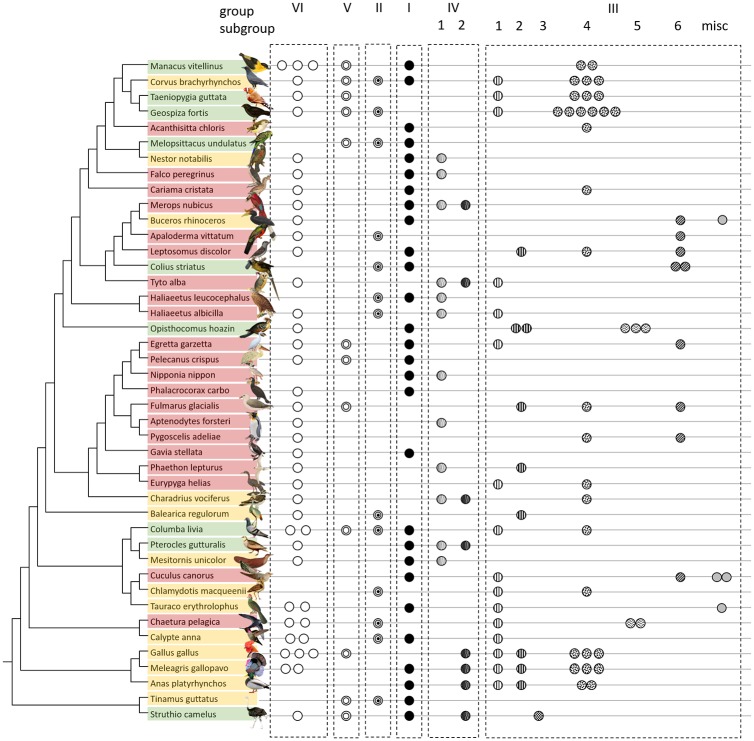
Classified UGT1E genes in bird species.Avian phylogenetic tree classifying UGT1 family genes (excluding those with sequences <200 bp). Species are color-coded based on feeding habits: red, carnivorous; yellow, omnivorous; and green, herbivorous. Illustrations of Anas platyrhynchos, Aptenodytes forsteri, Columba livia, Gallus gallus, Meleagris gallopavo, Struthio camelus, and Taeniopygia guttata were modified from the Togo picture gallery (http://togotv.dbcls.jp/ja/pics.html), licensed under CC-BY 4.0 Togo picture gallery by the Database Center for Life Science (DBCLS), Japan. Other illustrations were modified from public domain resources.